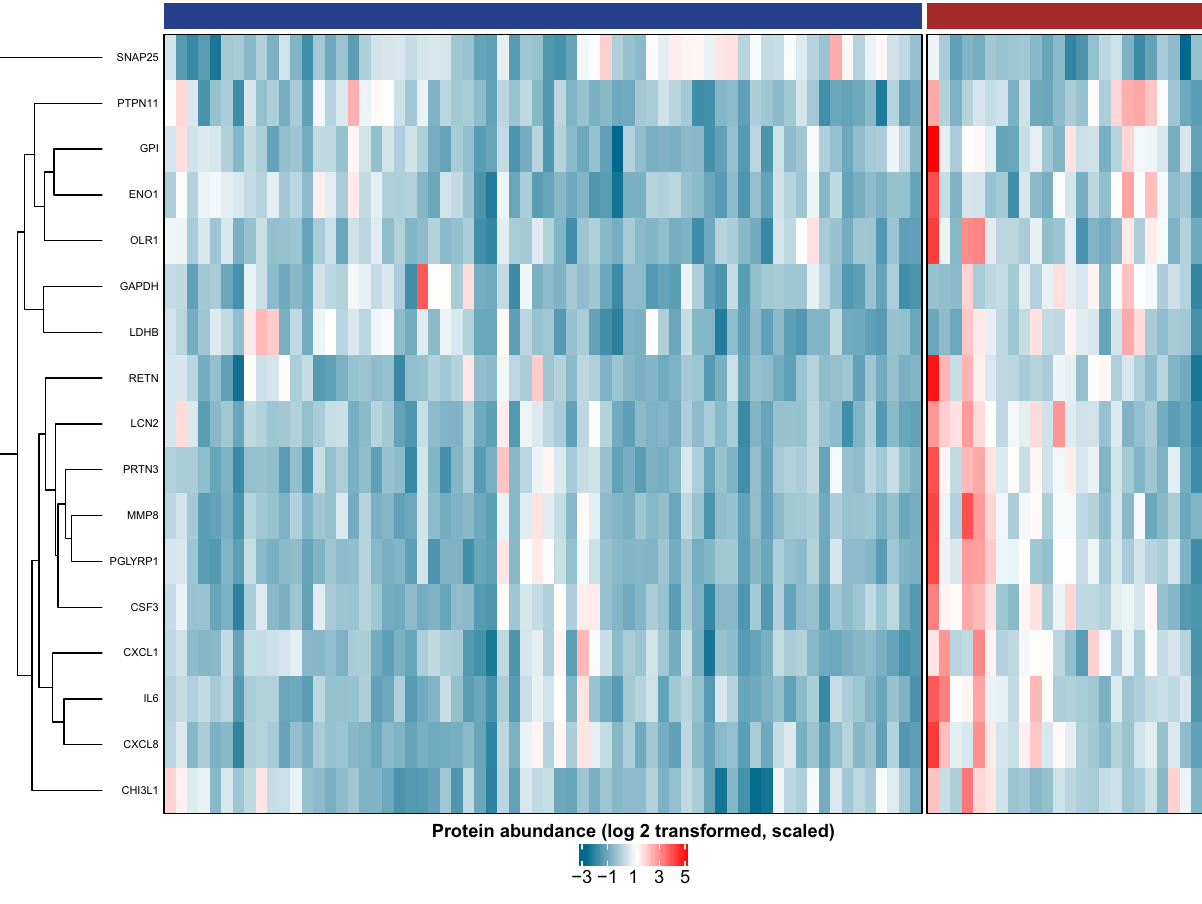
Figure 5. Clustered heatmap of protein data. The 17 proteins that were dysregulated in women destined for imminent delivery independent of cervical length were clustered using hierarchical clustering with correlation distance. Higher abundance of amniotic fluid protein levels is represented by a darker red